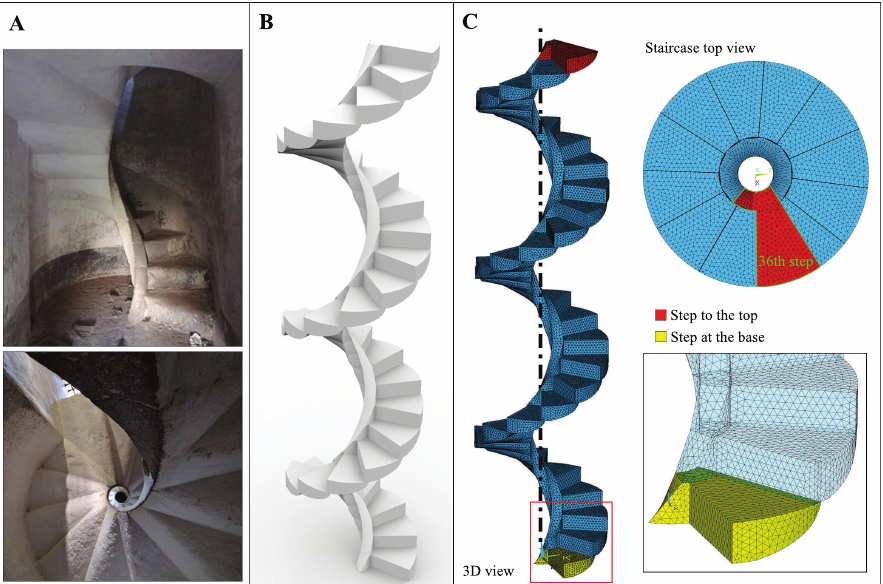
Figure 3. Helicoidal staircase of Nisida: ( A ) Photographs by the authors; ( B ) in silico geometrical model; ( C ) Helicoidal FE model of